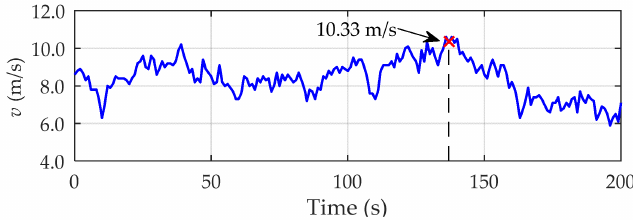
Figure 8. Actual wind speed profile used in the time domain